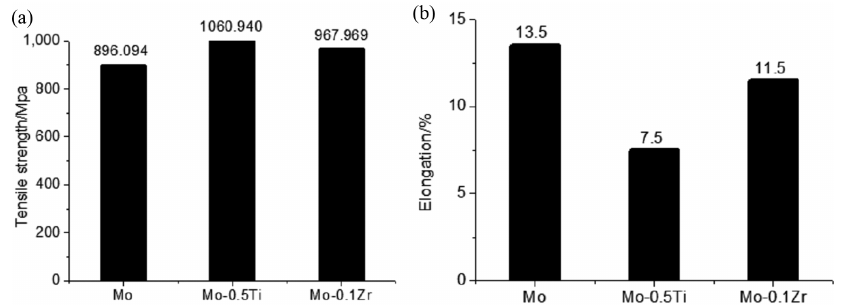
Figure 5: Tensile strength and the elongation of molybdenum, Mo-0.5Ti and Mo-0.1Zr at room temperature.